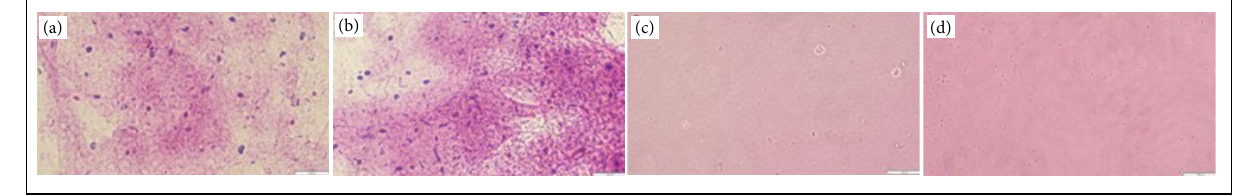
Figure 4 - Hydrogel stained with hematoxylin and eosin. ( a and b ) Hydrogel from in-natura skin with cellular nuclei stained in purple, and ( c and d ) hydrogel from decellularized skin without cellular